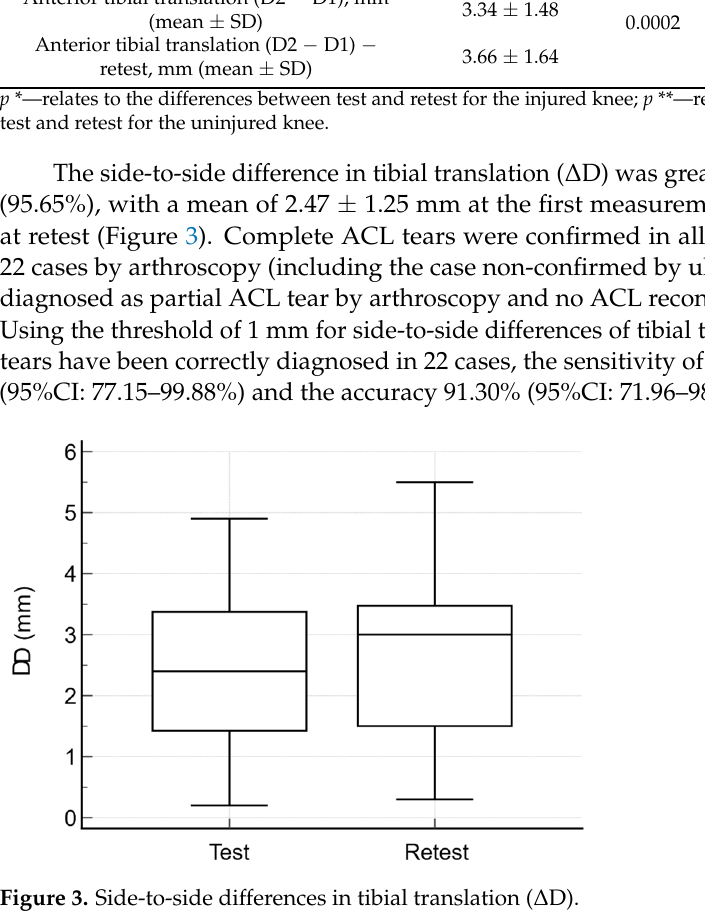
Table 1. Anterior tibial translation in injured and non-injured knee. Injured knee p * Uninjured knee p ** Anterior tibial translation (D2 − D1), mm (mean ± SD)